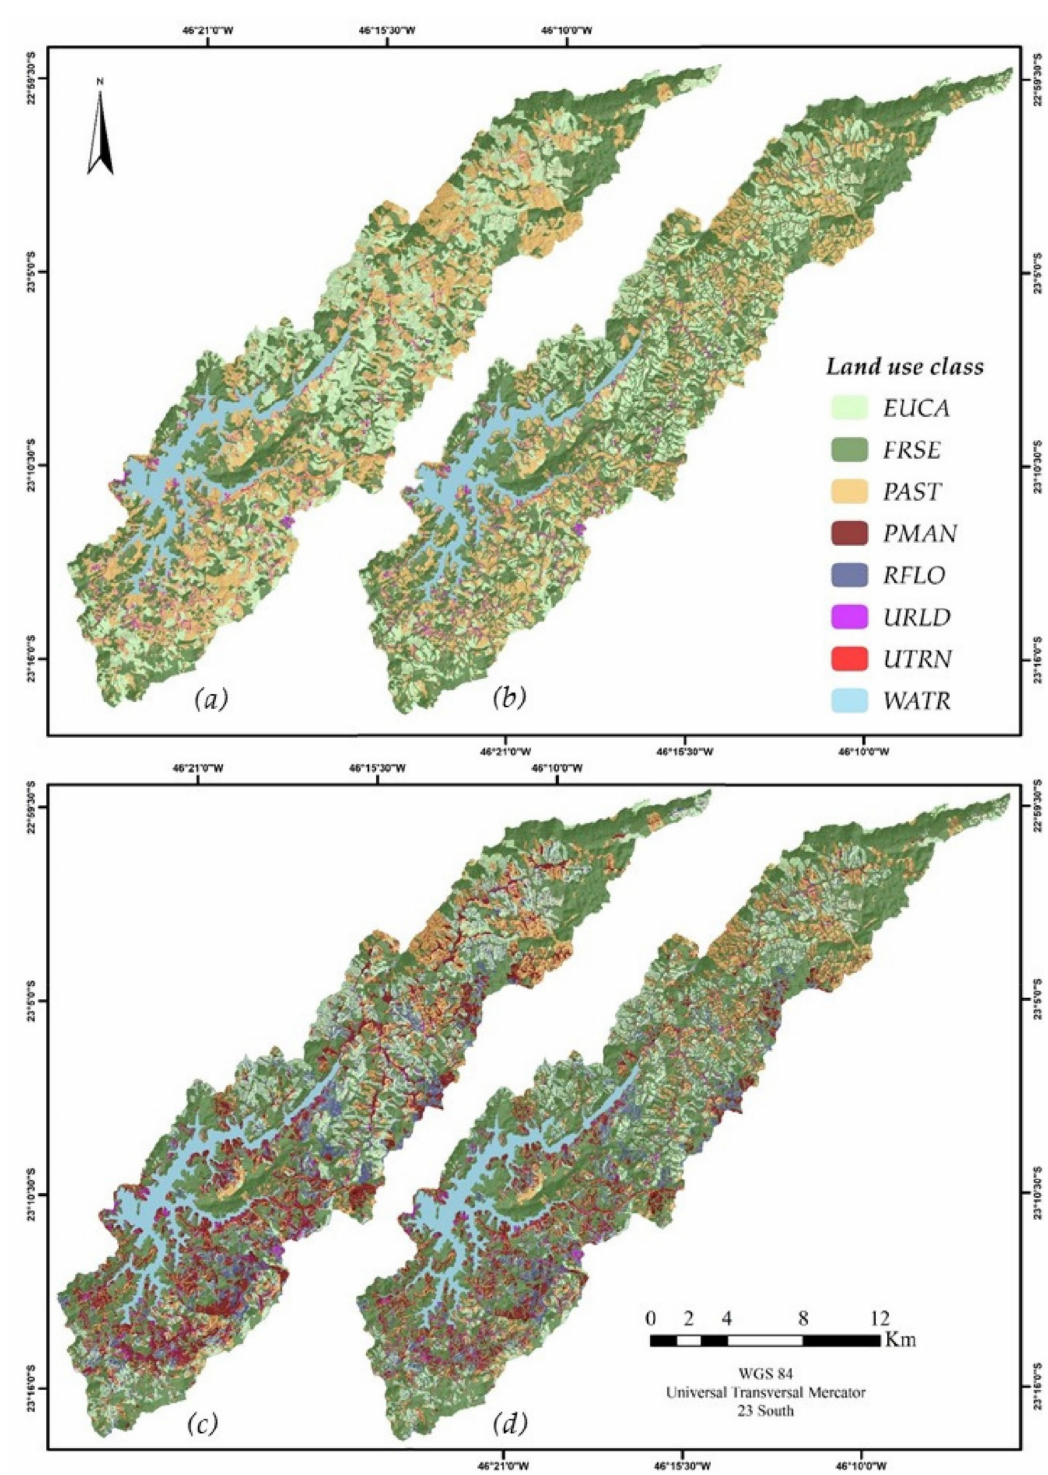
Figure 2. Land use map constructed and applied in each land use land cover (LULC)